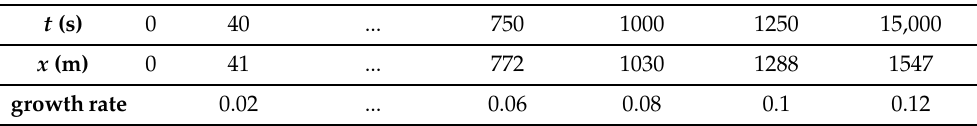
Figure 2. The non dimensional SGN soliton solution on a water surface at finite depth h = 0.26 m, and the wind speed at 10 m U 10 = 4.35 m/s, is plotted on an unscaled x -axis at times t = 750 s, t = 1000 s, t = 1250 s and t = 1500 s. Table 2. The growth rate of the SNG solitary wave at different times and positions, for depth h = 0.26 m, and wind speed at 10 m U 10 = 4.35